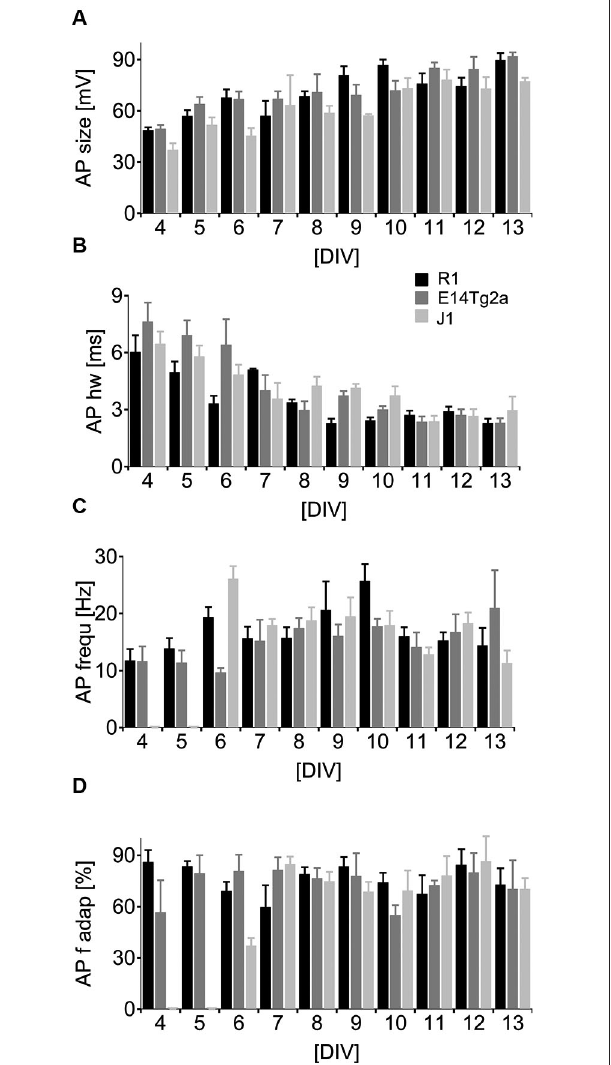
FIGURE 4 | Neuronal spiking patterns as a function of developmental age. (A–D) Analysis of the spiking parameters in neurons derived from of R1 (black), E14T2ga (gray) and J1 (light gray) mES cells as a function of time from DIV 0–13 in culture. Cells were subject to a 0.8 s depolarizing somatic current pulse. (A) Data for the amplitude of the first AP, (B) the half-width at half height for the first AP, (C) the initial firing frequency and (D) the frequency at the end of the train relative to the initial firing